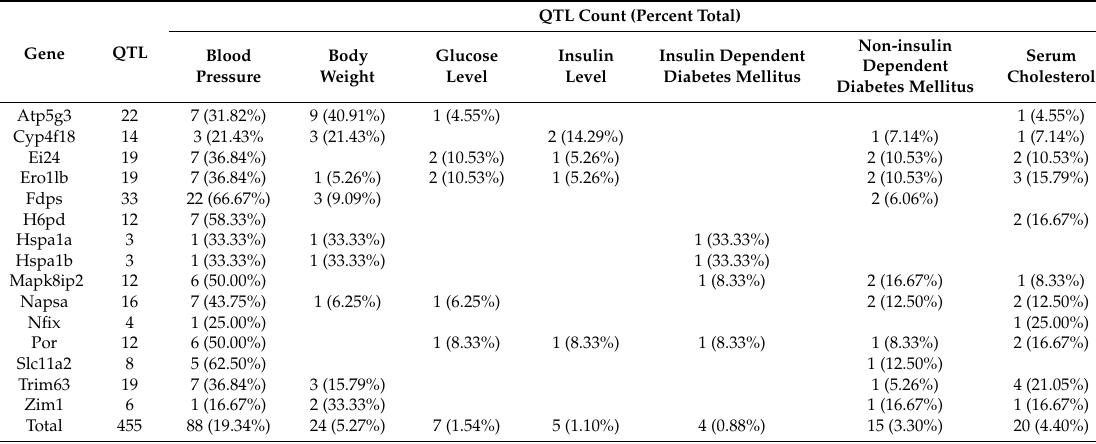
Table 4. Quantitative trait loci (QTL) related to metabolic processes that correspond to differentially bound histone peaks in the HF-diet exposed